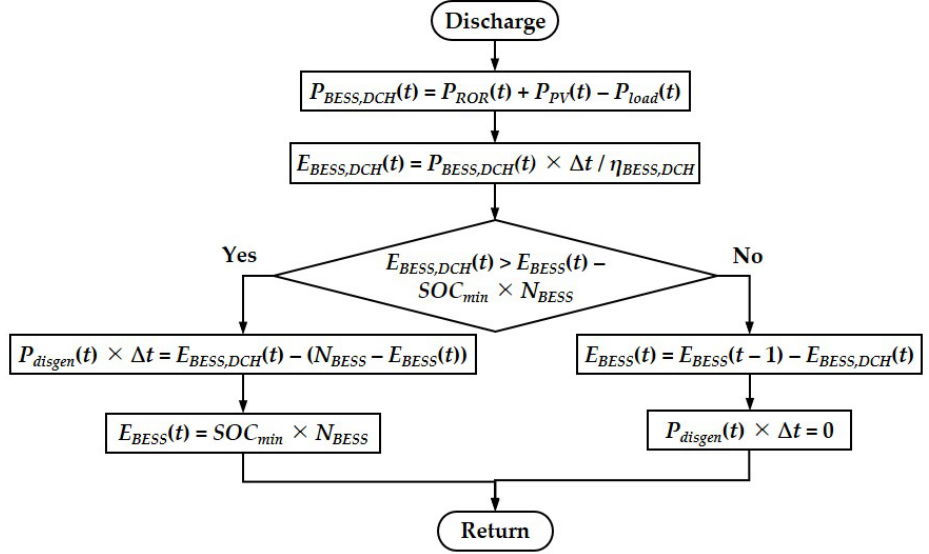
Figure 9. Flowchart of HREM discharging